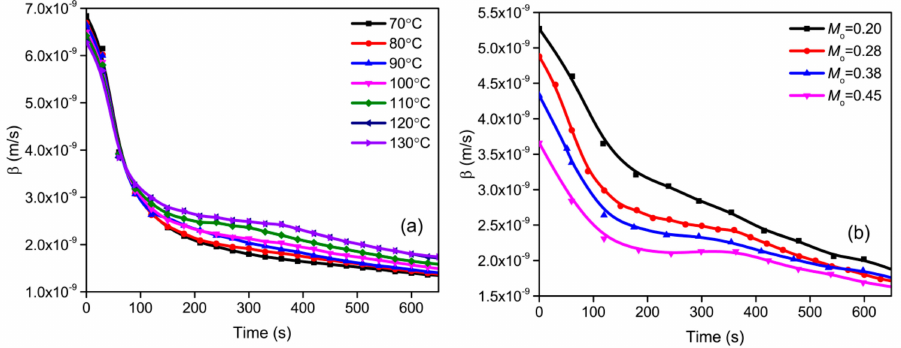
Figure 8. Distribution of mass transfer coefficient during the drying process: ( a ) for different drying temperatures; ( b ) for different initial moisture